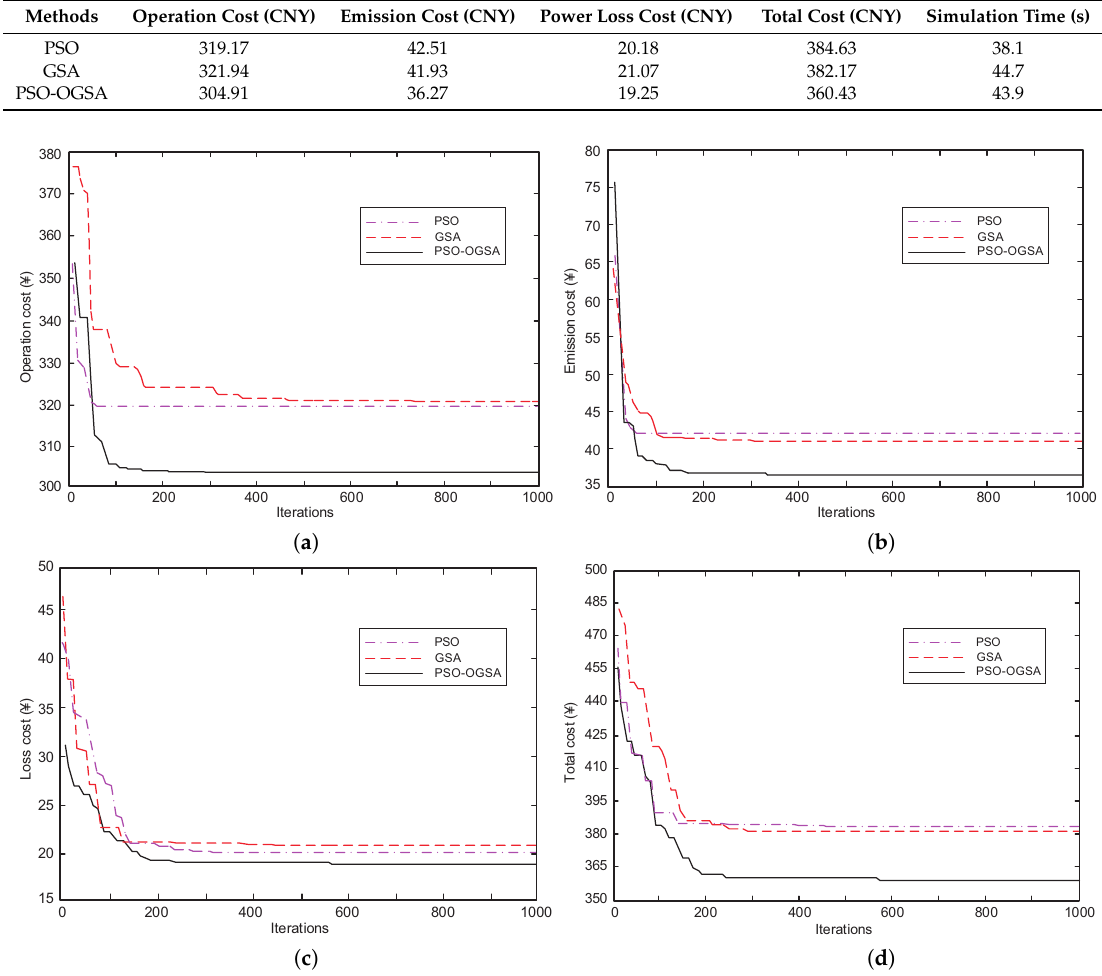
Table 6. Comparison of the detail data for the test microgrid.